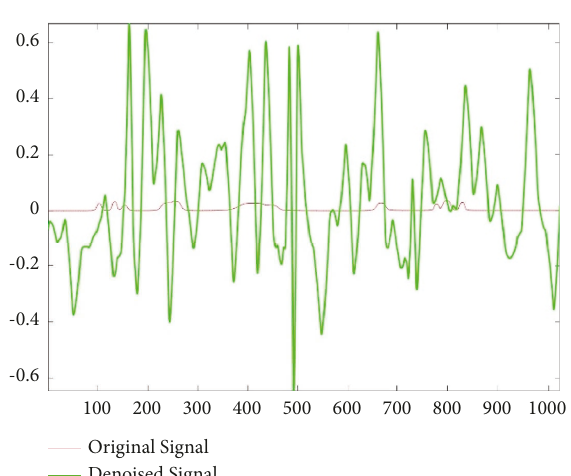
Figure 6: current signal during short circuit fault after denoising and applied